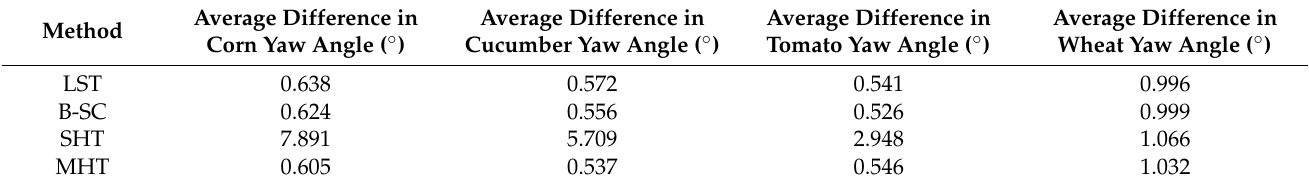
Table 5. Yaw angle statistics under different crop conditions based on the proposed model. LST stands for least squares method. B-SC stands for B-spline curve. SHT stands for standard Hough transform. MHT stands for median-point Hough